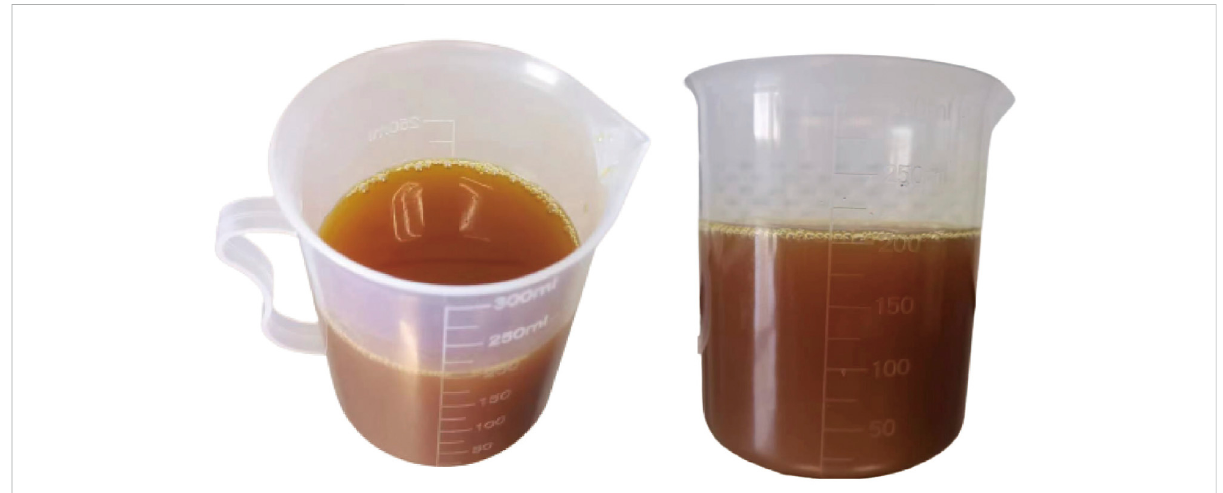
FIGURE 2 Jiedu Shengji decoction